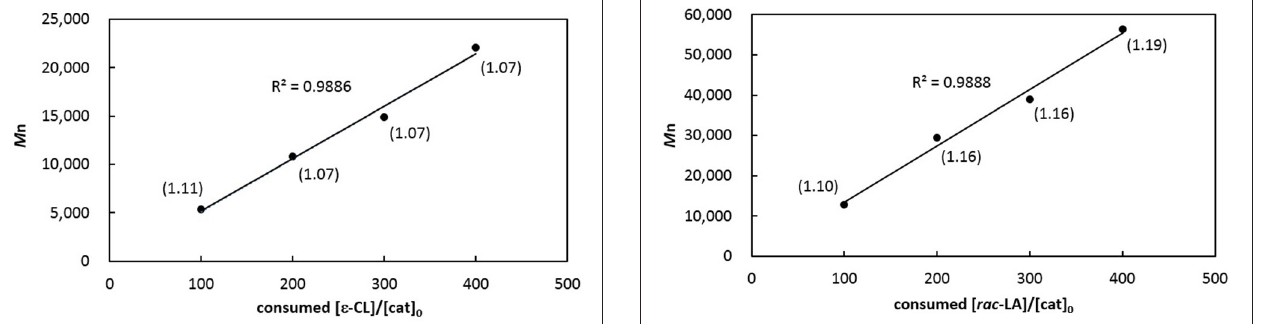
FIGURE 6 | Linear plot of corrected M n of PLAs vs. monomers consumed to [ 3a ]Al(OCH 2 Ph) ratios (entries 5–8 in Table 2 ). Numbers shown in parentheses indicate their corresponding